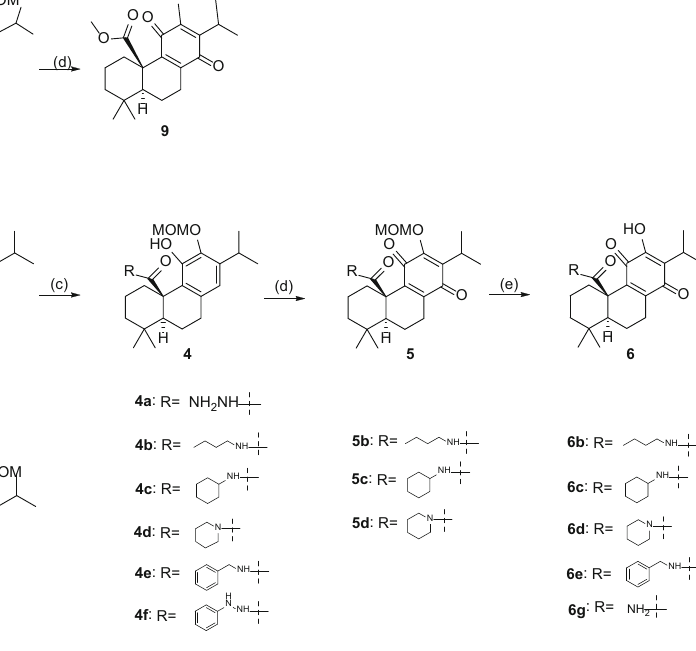
Scheme 1 Synthetic route of target compounds. Reagents and conditions: a EDCI, DMAP, DCM, rt, 3 h; 95%, b MOMCl, DIPEA, DCM, rt, 12 h; 88%, c Amine or hydrazine, THF, rt, 0.5–5 h;